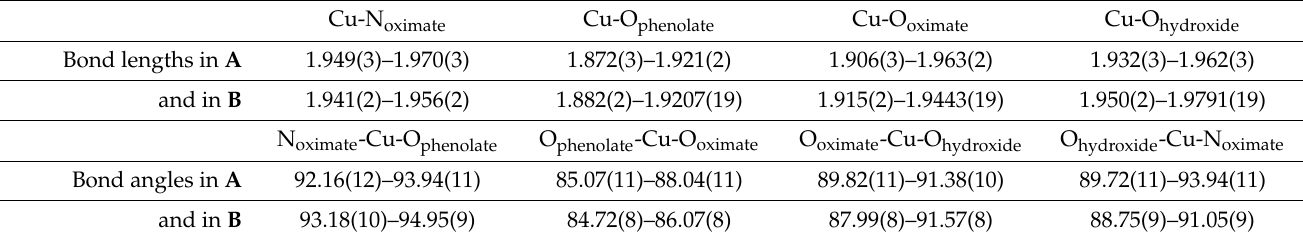
Table 2. Ranges of bond lengths/Å and angles/ o in the inner coordination spheres of the Cu atoms in the two crystalline form A and B